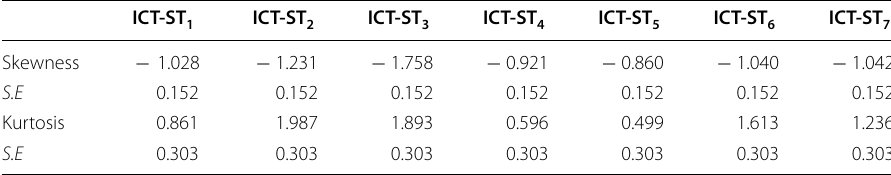
Table 3 Pre-service teachers’ self-efficacy in enriching teaching and learning with ICT: normality of ICT-ST data set